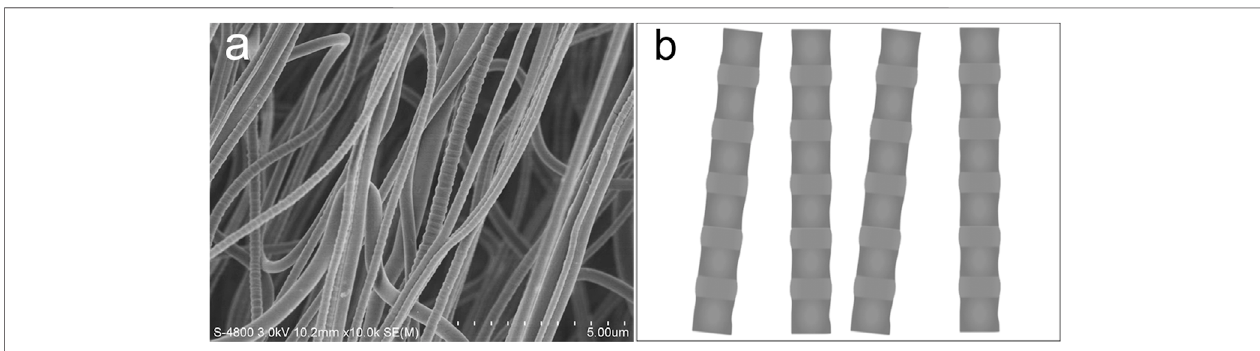
FIGURE 6 | (A) Morphology of the periodic unsmooth PVA nano fi ber. (B) Schematic diagram of the periodic bamboo-like unsmooth PVA nano fi ber.